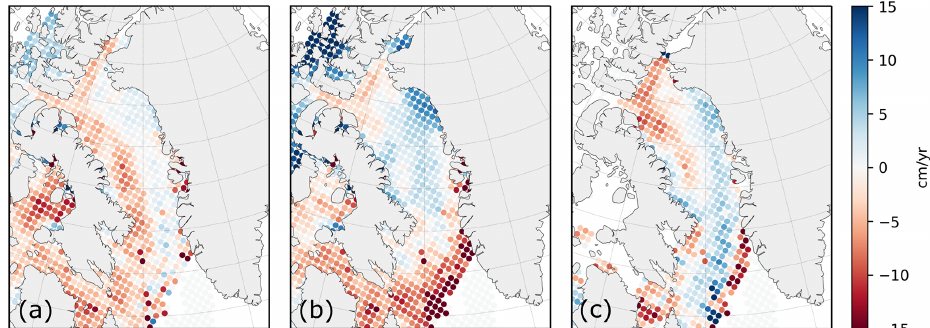
Figure 7. March sea ice thickness trends (2003–2020, ICESat + CryoSat-2 LARM) with different processing methods. (a) W99 snow depth + sigmoidal redistribution + W99 snow density, (b) PMW snow depth + piecewise redistribution + W99 snow density, and